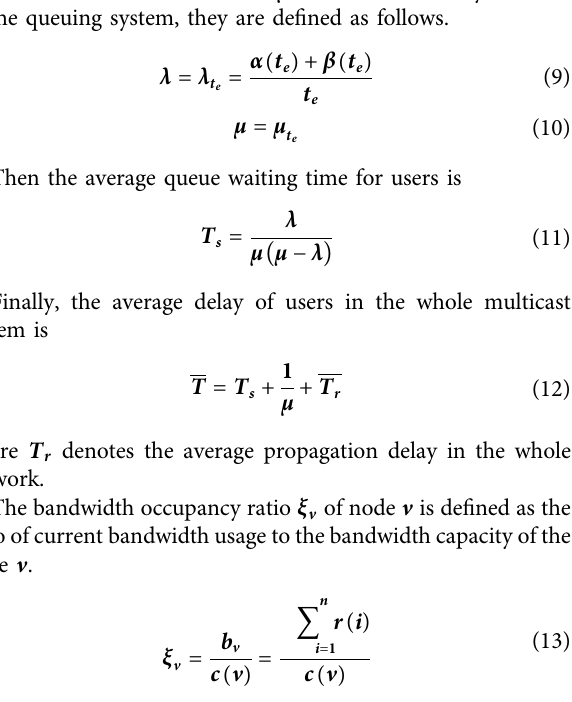
Frontiers in Communications and Networks |